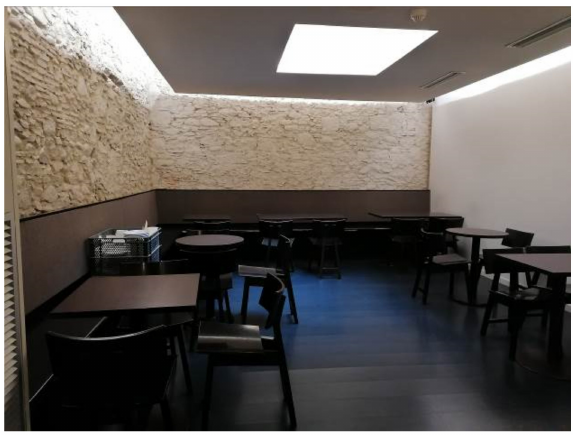
Figure 1. An empty cafeteria (own